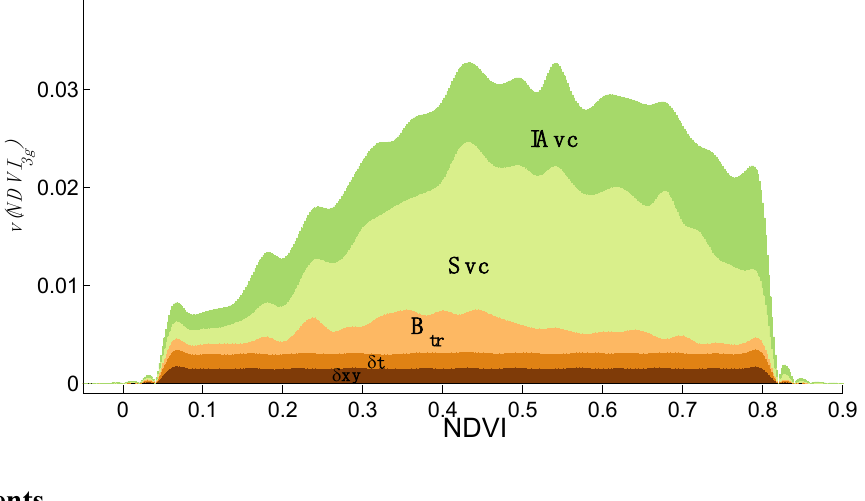
Figure 8. This figure shows the accumulated spatial coherence, temporal coherence, Bayesian, seasonal, and interannual uncertainties sum to an average 0.023 NDVI units (δ + δ + Bt + Svc + IAvc, respectively). The inter-annual variation increases xy t r proportionally to NDVI values but still it is lower than ±0.012 NDVI units. The major contributions to the uncertainty from seasonal variation occur within the NDVI interval from 0.3 to 0.7 where effects of vegetation phenology are